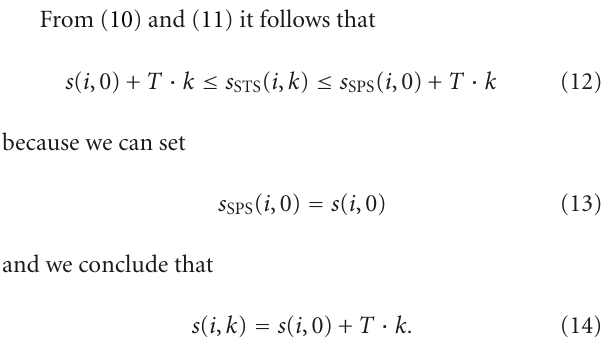
Figure 2: Actor q will enforce a minimum interval μ ( G ) between successive firings of actor i